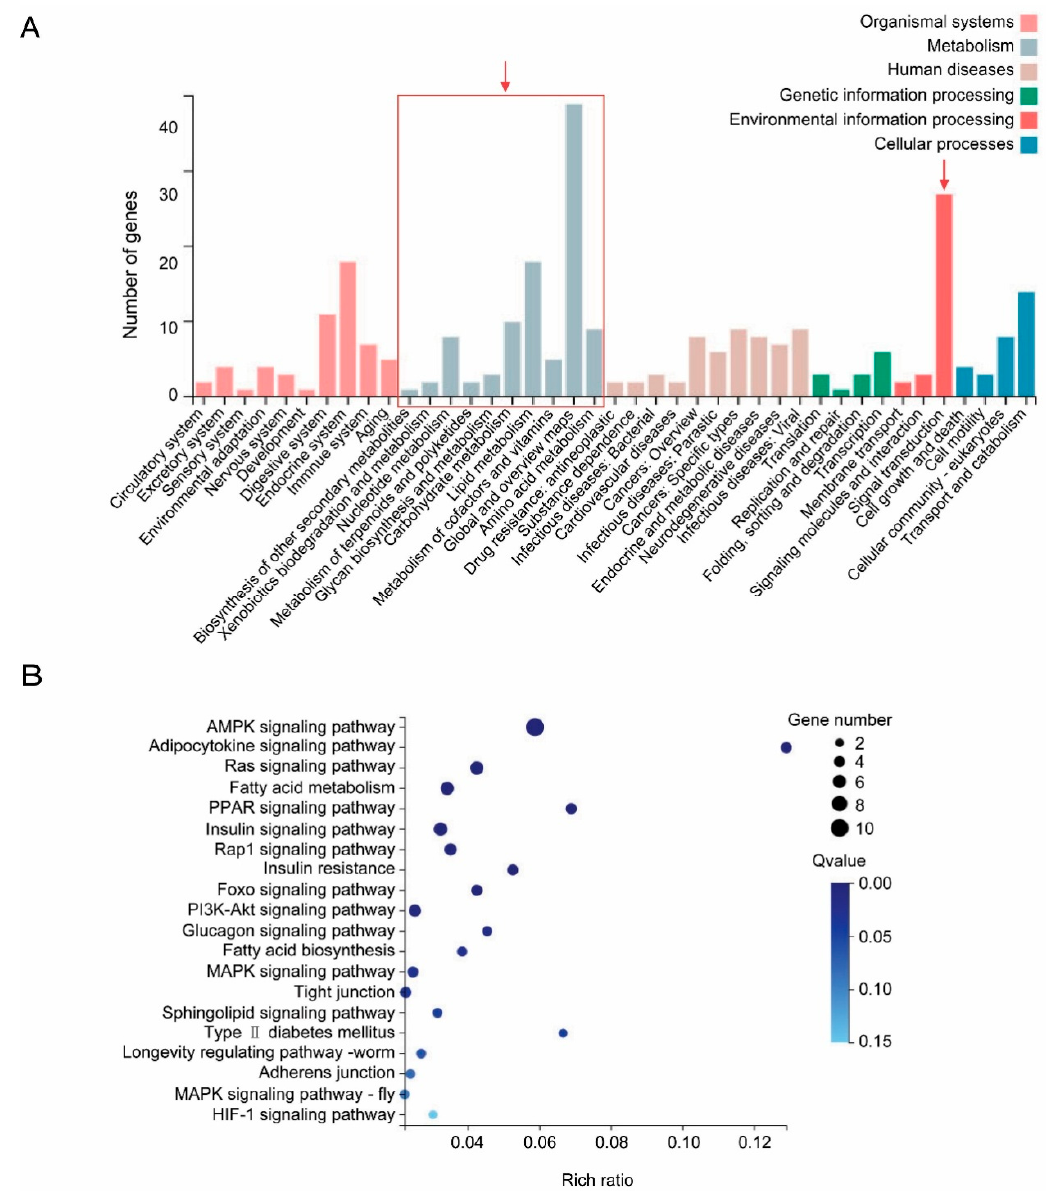
Figure 4. KEGG classifications and enrichment analysis of 235 common DEGs regardless of viral feeding time. ( A ) KEGG classifications, different colors stand for different functions. ( B ) KEGG enrichment analysis of DEGs related to signal transduction. The greater rich ratio and lower Q value mean greater intensiveness.